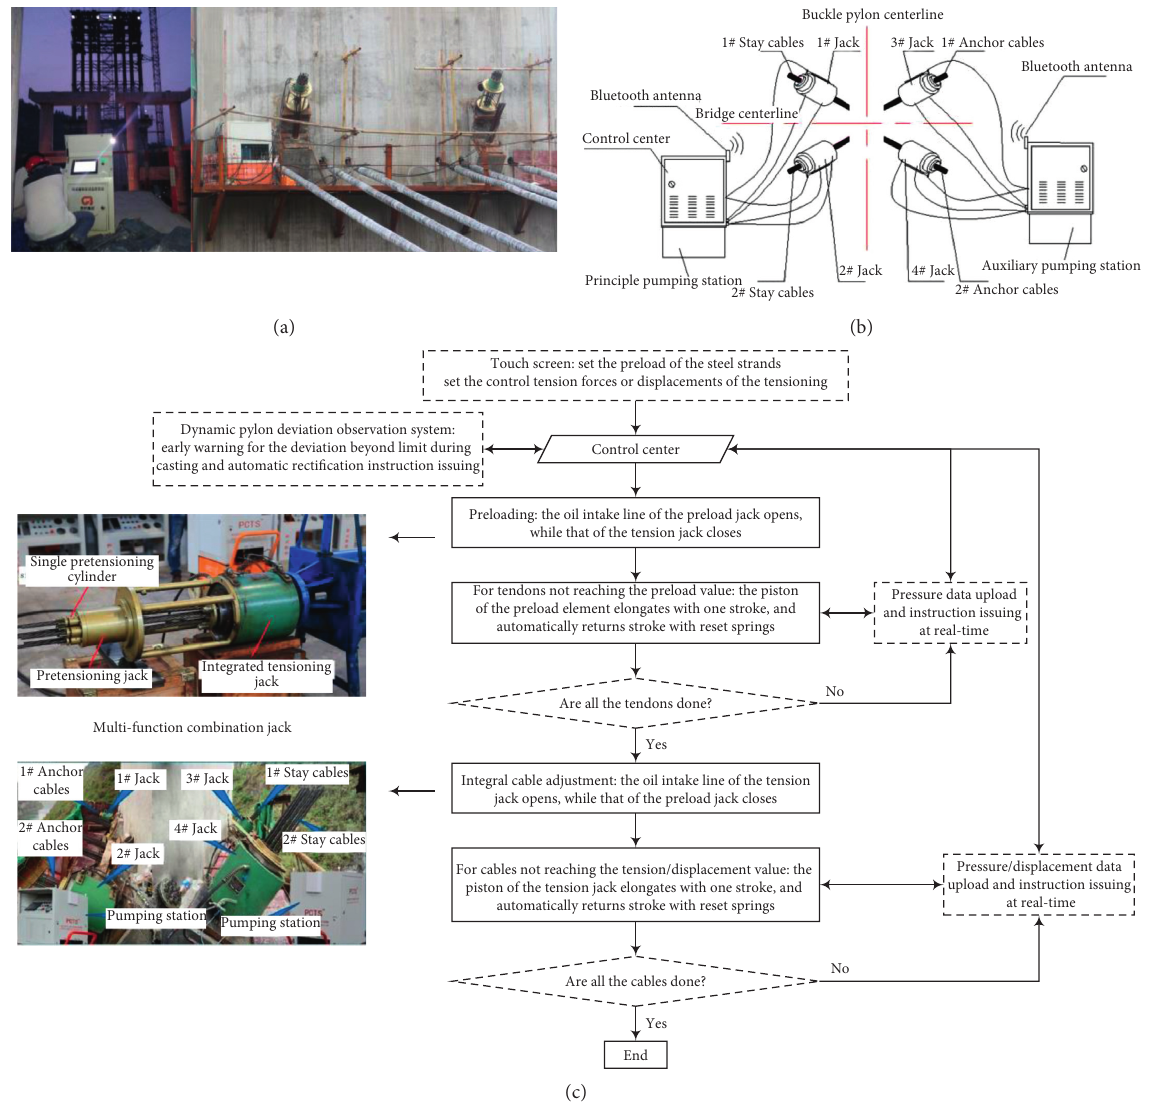
Figure 7: Working principle of the automatic cable adjustment control system. (a) Automatic monitoring-control of the cable tensioning. (b) Components of the automatic cable adjustment control system. (c) Principle of automatic preload and integral